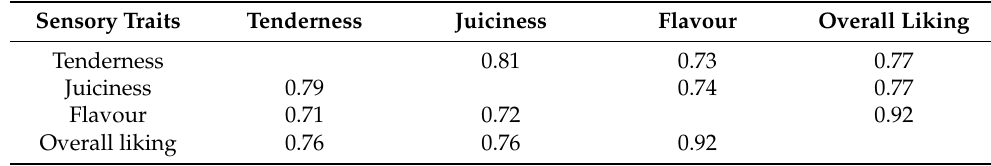
Table 5. Partial correlation coefficients for tenderness, juiciness, liking of flavour and overall liking for the shoulder (above diagonal) and leg (below diagonal) samples for Chinese